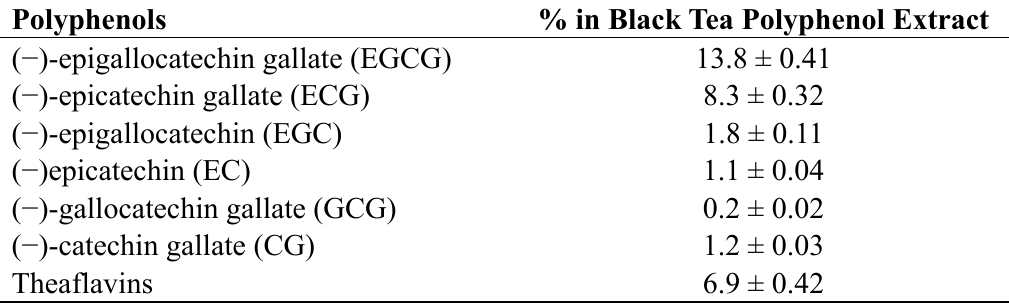
Table 2. Polyphenols in black tea polyphenol extract (BTPE)